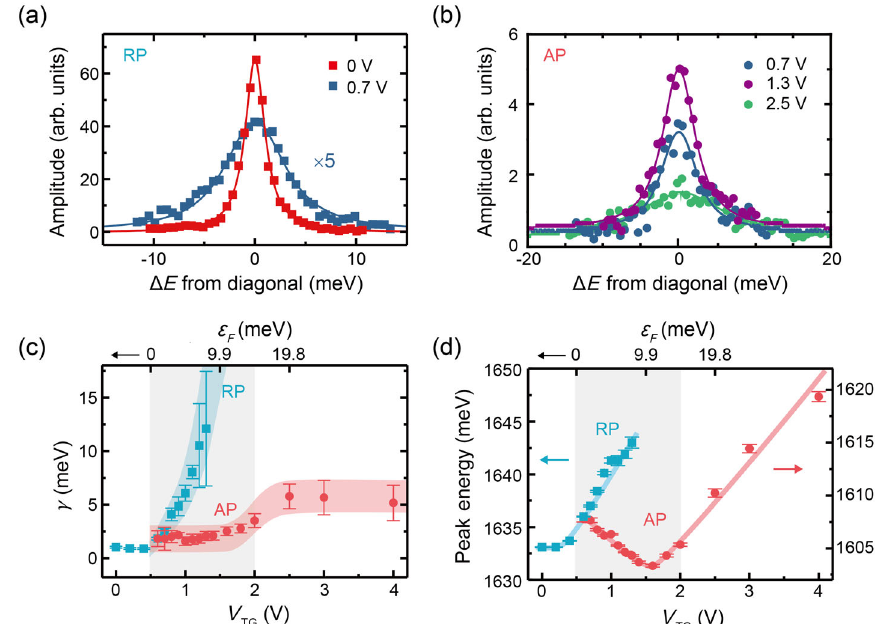
FIG. 3. Homogeneous linewidths and resonant energies of APs and RPs extracted from 2D spectra. Cross-diagonal line cuts of 2D spectra used to extract homogeneous linewidths for (a) RPs and (b) APs at a few selected top-gate voltages. The data points are fitted by a modified Voigt function as discussed in the Supplemental Material [21]. (c) Homogeneous linewidths and (d) resonant energy of RPs (blue) and APs (red) as a function of the top-gate voltage (bottom x axis) and corresponding Fermi levels (top x axis). The shaded gray area indicates the doping density range over which the polaron theory